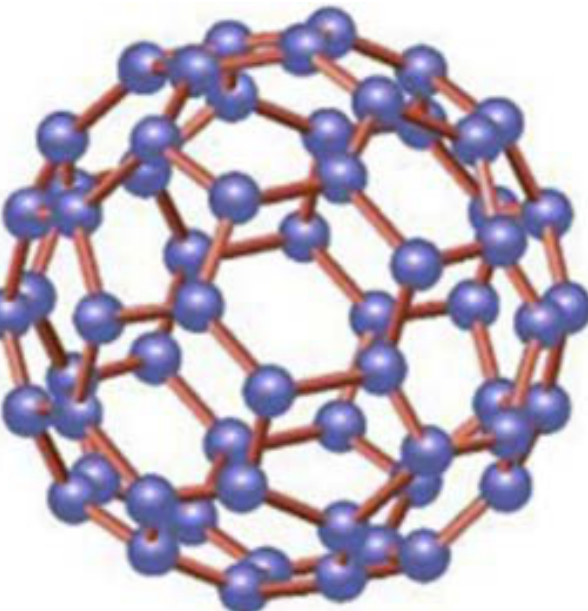
Figure 9. Fullerene C 60 (Reprinted with permission from Mohan, V.B. et al. [50]. Copyright 2018, with permission from Elsevier).